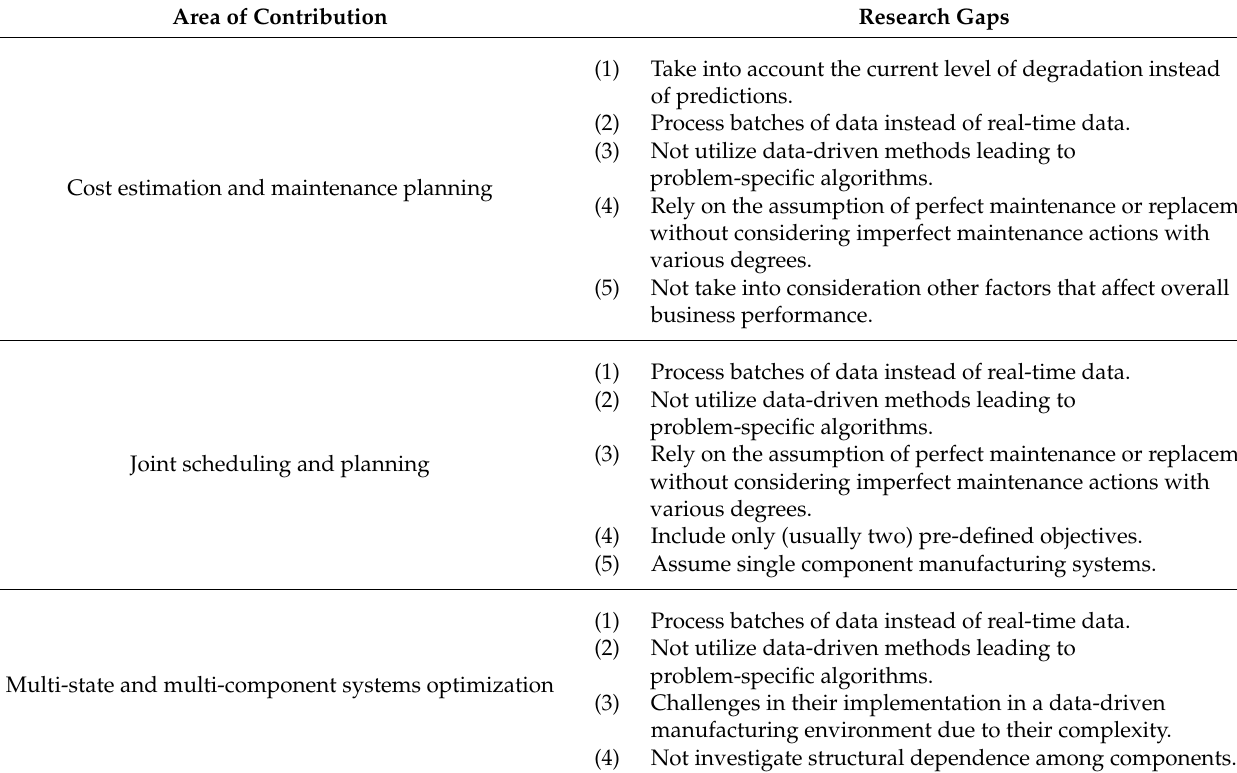
Table 4. The research gaps per area of